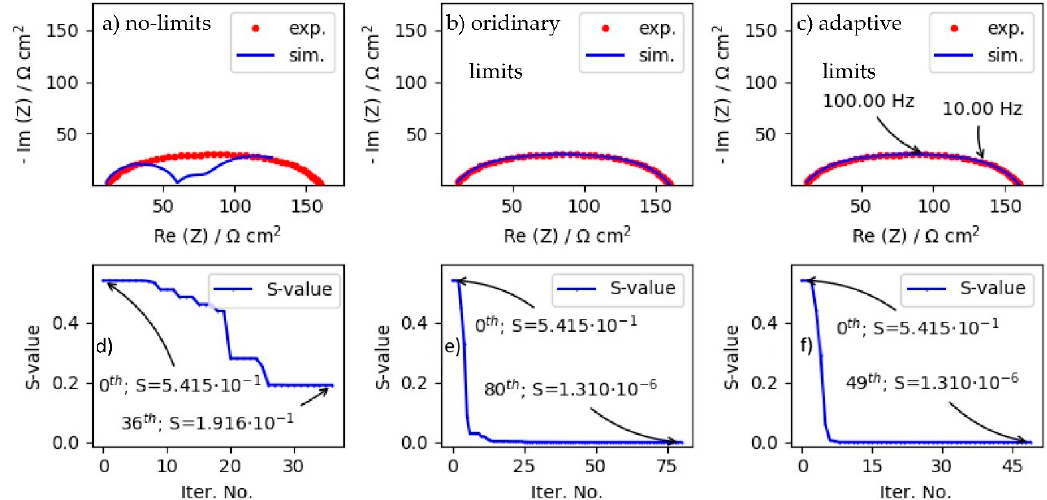
Figure 2. The impedance spectra of the ZARC data (subplots a – c ) and the corresponding S -value data (subplots d – f ). EEC R(QR)(QR)(QR) (Figure 1) was used in the fitting attempts.